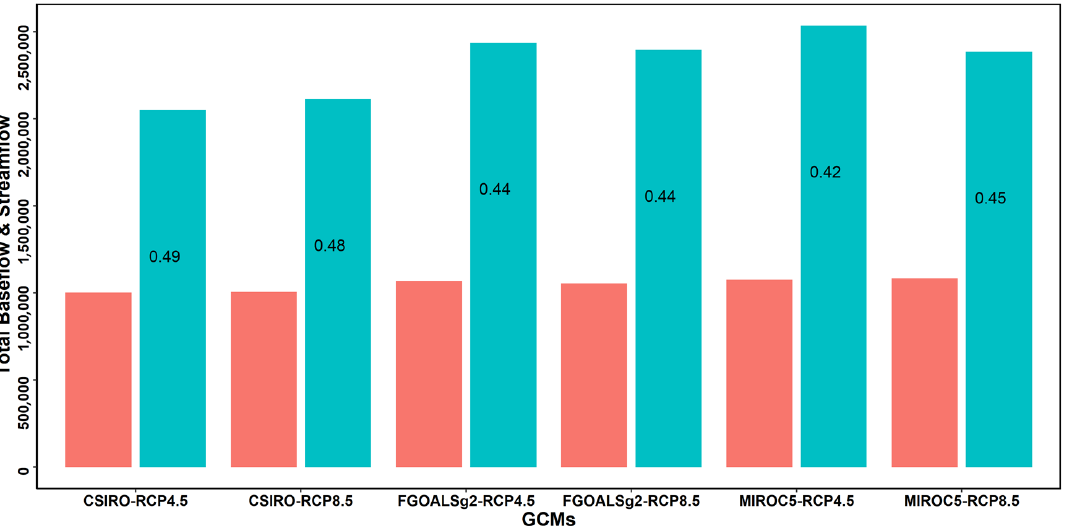
Figure 8. Total baseflow and streamflow for each GCM. Numbers in bars are the baseflow index. Red bars are the total baseflow, and blue bars are the total streamflow.